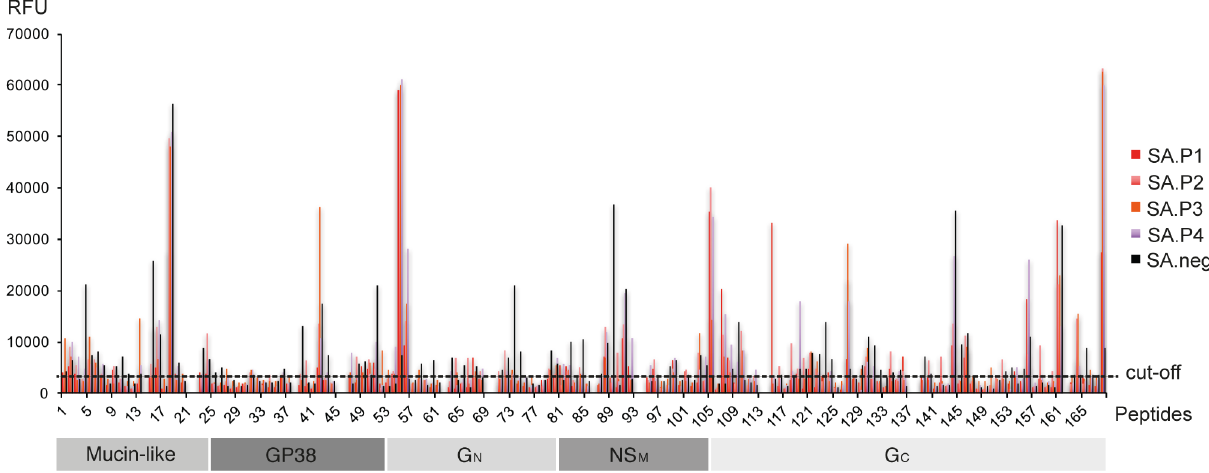
Fig 4. Reactivity of pooled South African sera. Four CCHFV survivor pools (red) and one uninfected pool (black)) against 168 peptides representing the complete precursor glycoprotein of CCHFV (Turkish strain).